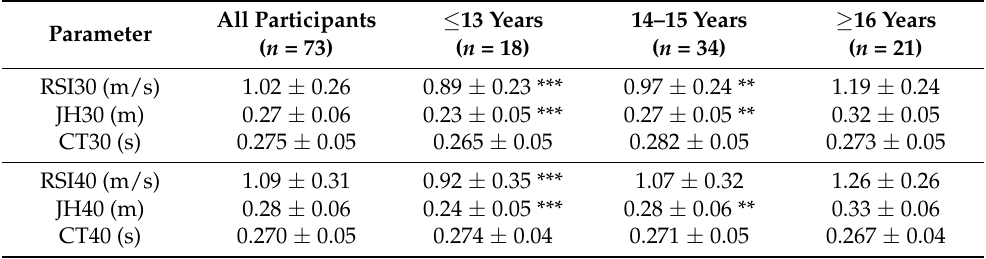
Table 2. Drop jump performance parameters of the participants for DJ30 and DJ40 (mean ± SD). Table 4. Correlations between DJ40 performance and stiffness parameters (mean ± SD). All Participants Parameter Parameter